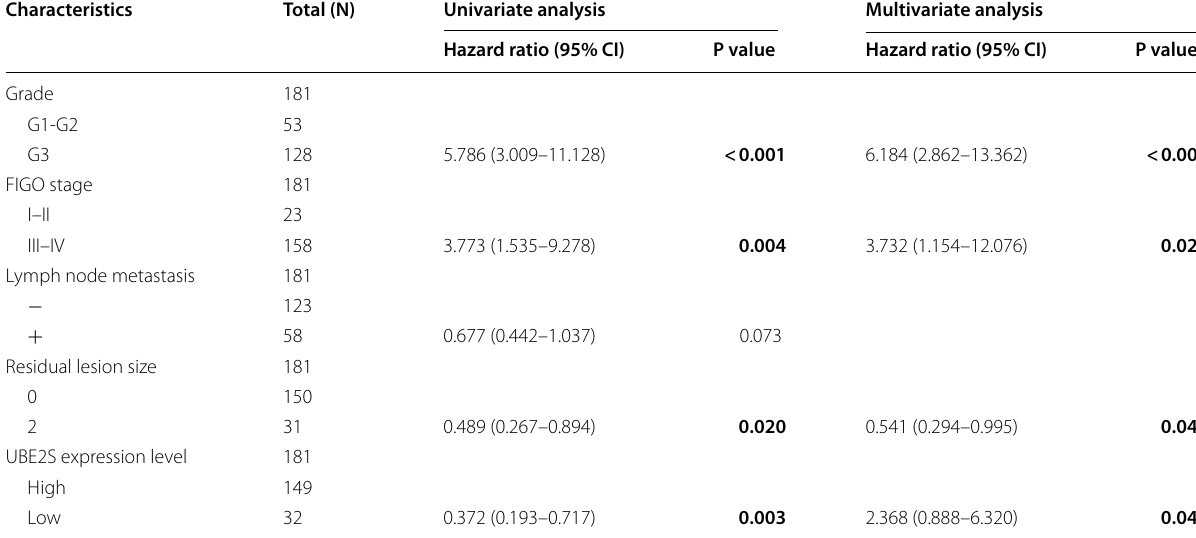
Table 2 Univariate and multivariate Cox regression analyses of UBE2S